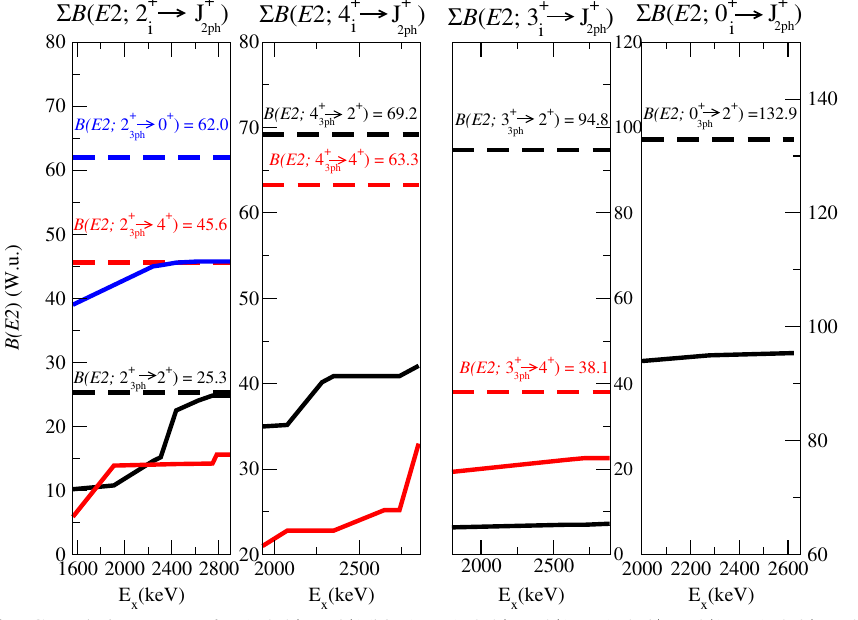
)(blue), B ( E 2;2 + → 2 + ), B ( E 2;4 + → 2 + ), B ( E 2;3 + → 2 + ), and 2 2 2 2 ), B ( E 2;4 + → 4 + ), and B ( E 2;3 + → 4 + )(red) values (in W.u.) v s . excitation 1 1 1